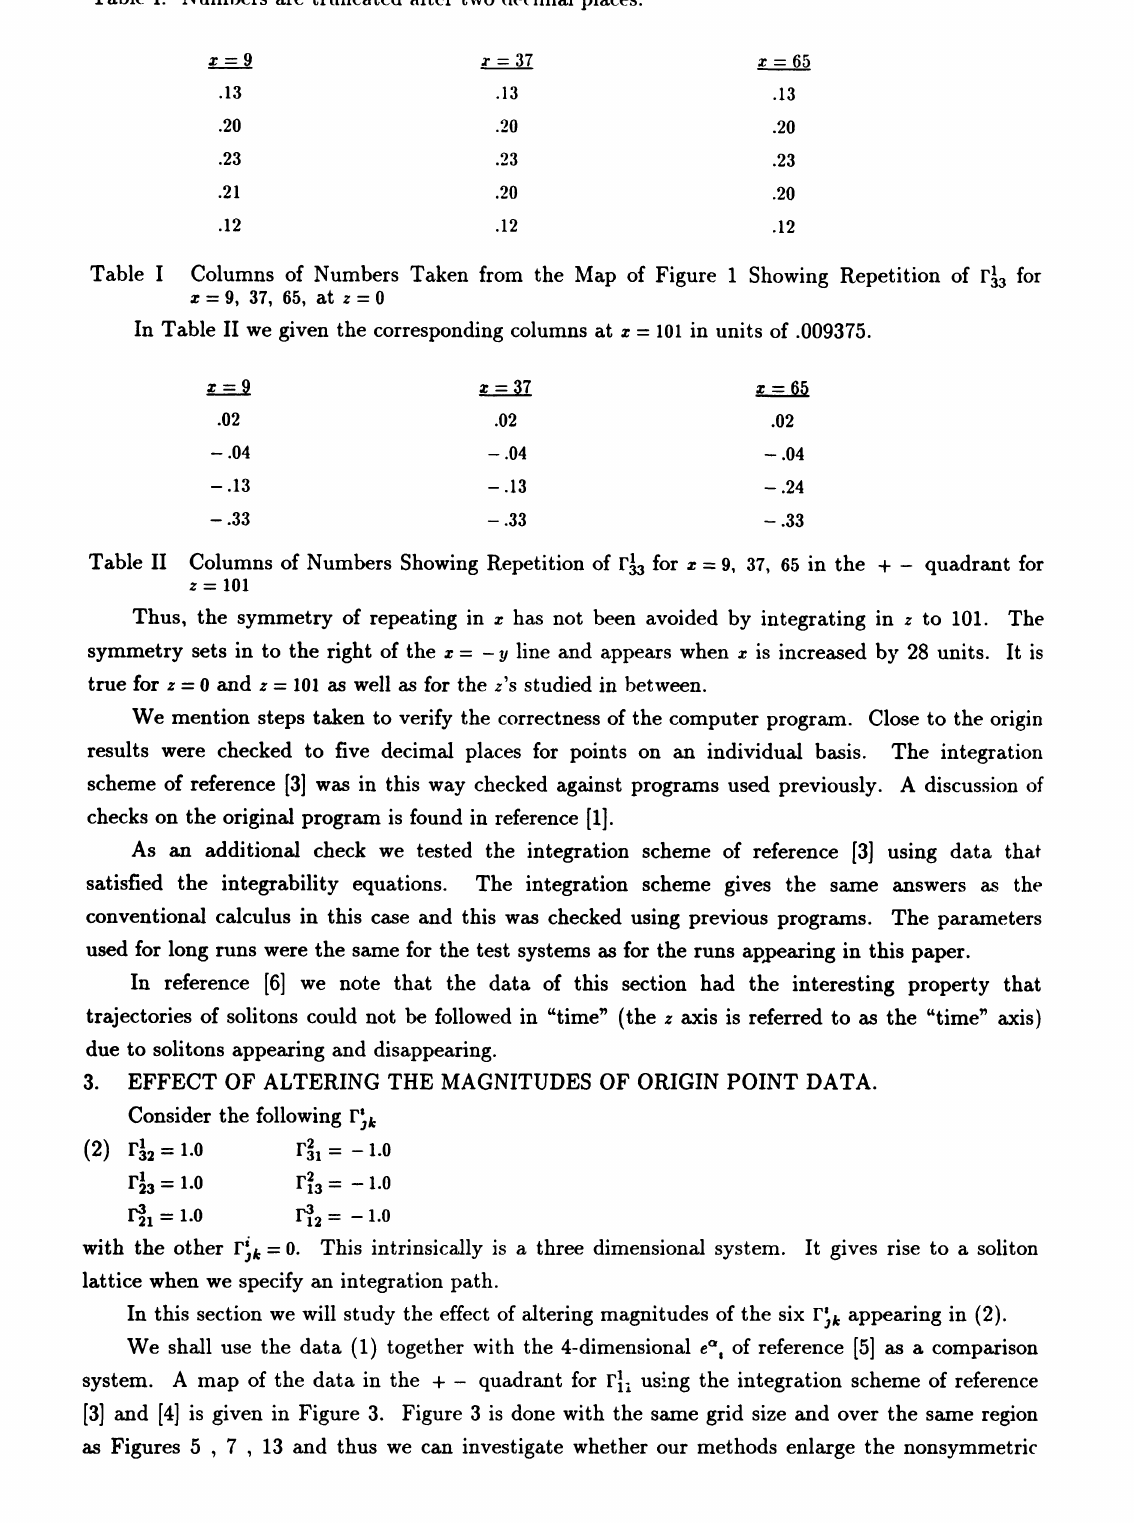
Columns of Numbers Taken from the Map of Figure 1 Showing Repetition of F3 for z 9, 37, 65, at 0